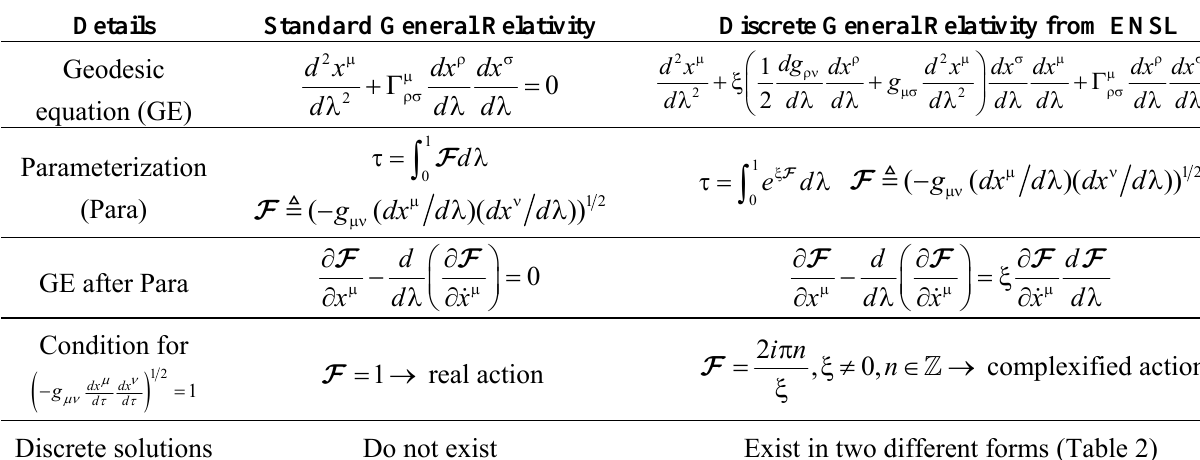
Table 1. Main differences between standard general relativity (GR) and GR arising from exponential non-standard Lagrangians